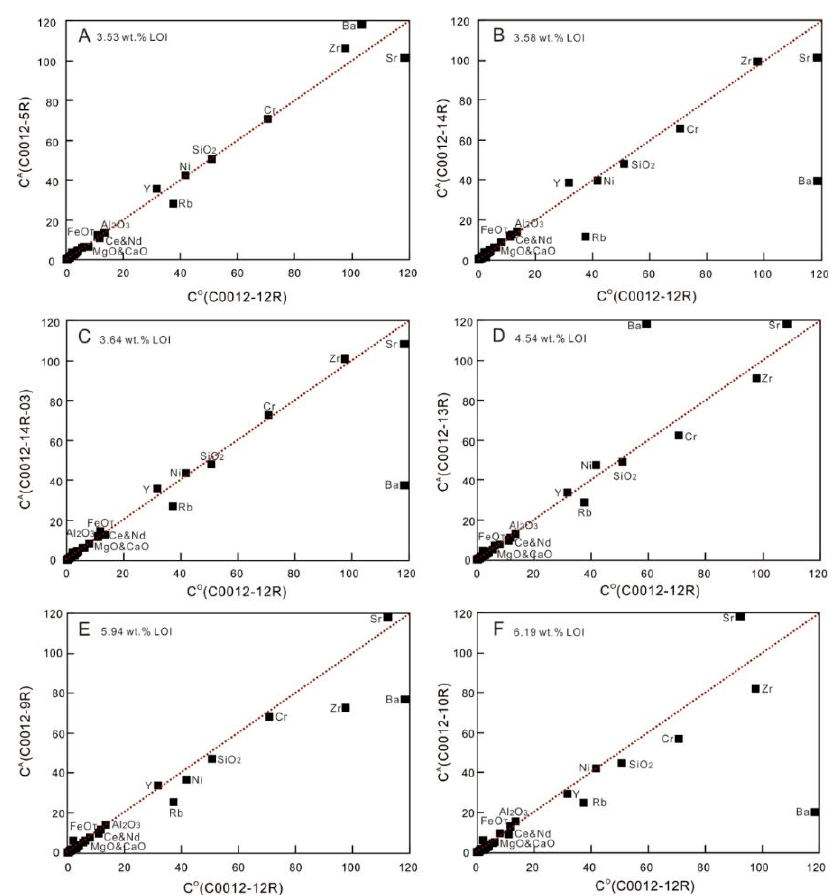
Figure 12. Isocon diagrams of six volcanic rocks with increasing loss on ignition (LOI) contents (C A ) from Shikoku Basin showing gains and losses of single-element concentrations compared to samples with minimal alteration (C O ). C0012-12R sample with minimal alteration (2.15 wt.% LOI) versus ( A ) C0012-5R sample with 3.53 wt.% LOI, ( B ) C0012-14R sample with 3.58 wt.% LOI, ( C ) C0012-14R-03 sample with 3.64 wt.% LOI, ( D ) C0012-13R sample with 4.54 wt.% LOI, ( E ) C0012-9R sample with 5.94 wt.% LOI, and ( F ) C0012-10R sample with 6.19 wt.% LOI.